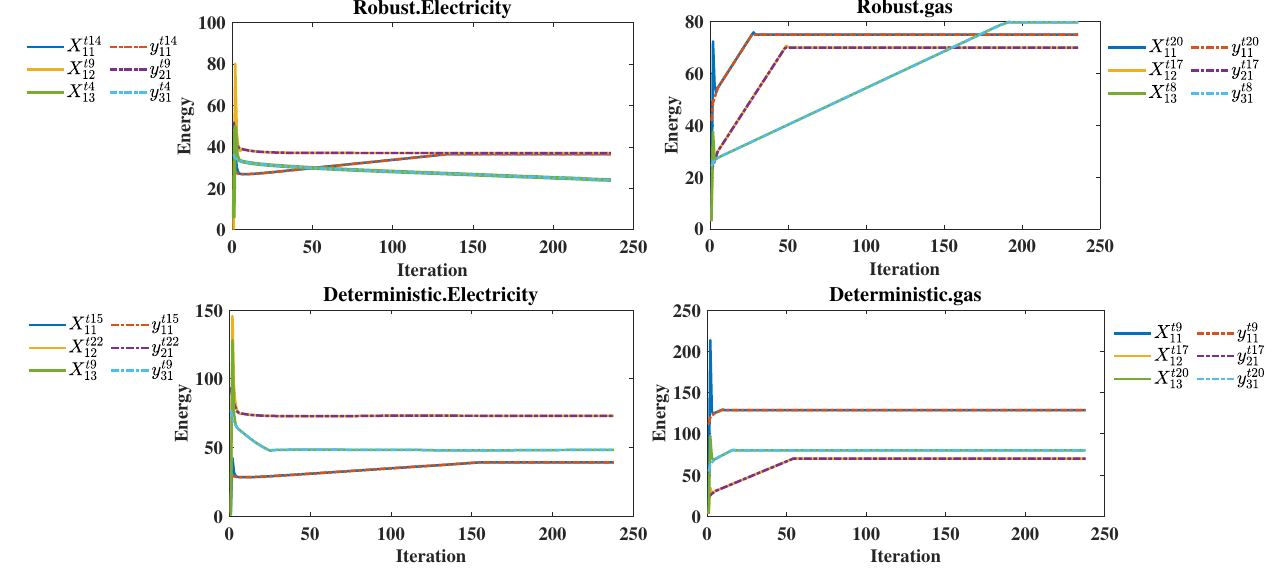
Figure 6. The prediction of electrical and thermal loads of each